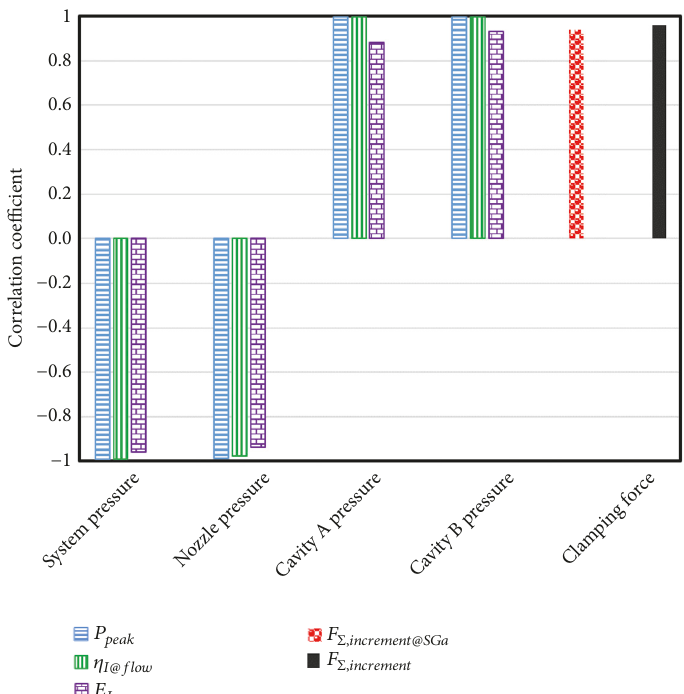
Figure 18: Correlation between quality indexes and product weight for various melt quality fluctuations.